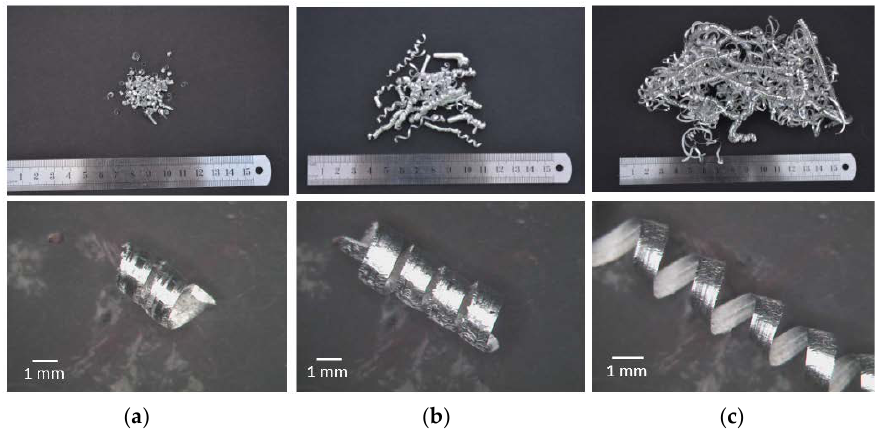
Figure 11. Chip morphology for: ( a ) v c = 40 m/min, f = 0.15 mm/rev; ( b ) v c = 60 m/min, f = 0.10 mm/rev; ( c ) v c = 80 m/min, f = 0.05 mm/rev.